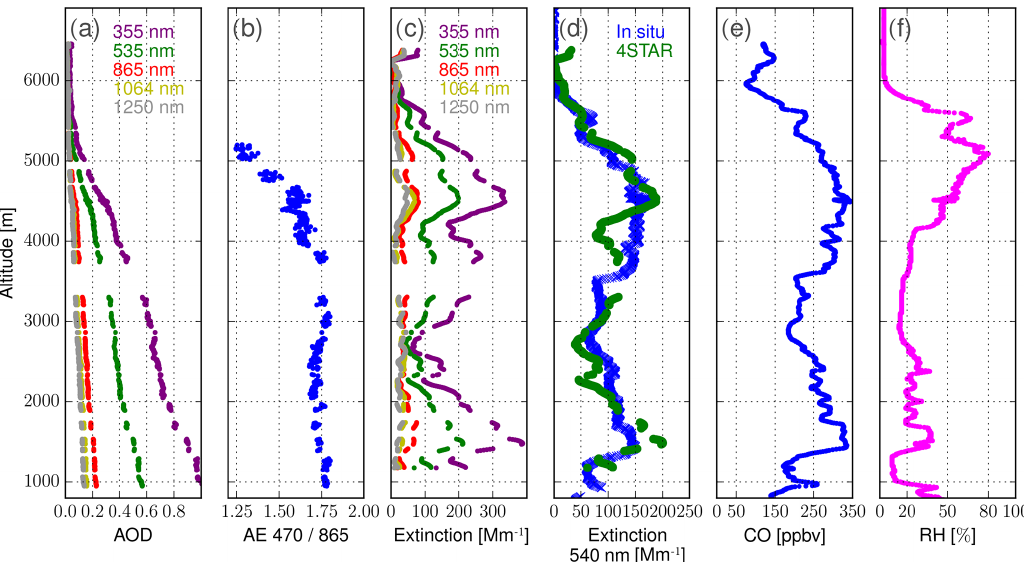
Figure 13. Aerosol optical properties profiles from the same case on 20 September 2016 as in Fig. 11. (a) Vertical profile of AOD at a few selected wavelengths. (b) AE 470 / 865 profile, (c) derived extinction coefficient from 4STAR AOD at a few wavelengths, (d) extinction coefficient at 540nm derived from 4STAR AOD and in situ measurements, (e) CO concentration, and (f) ambient relative humidity